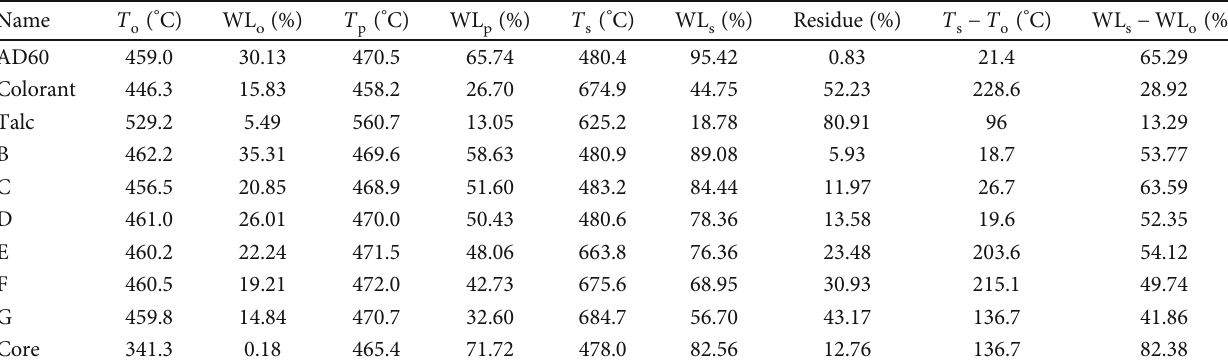
Figure 2: SEM micrographs of coextruded WPC with a talc- fi lled shell. (a) Core-shell interface. (b) Shell layer. Table 2: Data obtained from